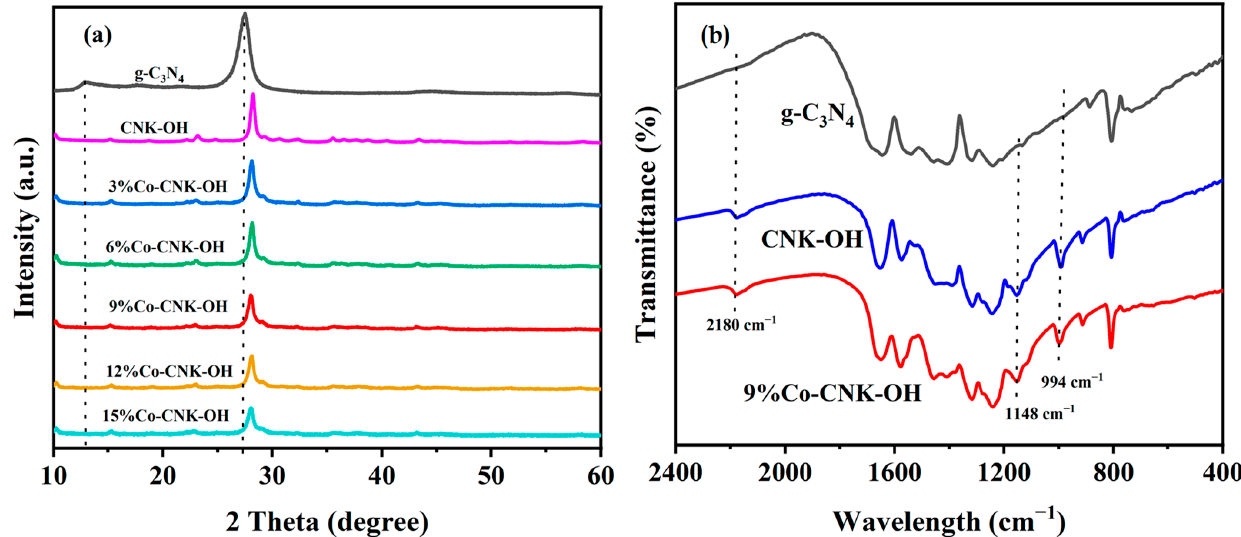
Figure 1. The XRD patterns of g-C 3 N 4 , CNK-OH and Co-CNK-OH ( a ) and FT-IR spectra of g-C 3 N 4 , CNK-OH, and 9%Co-CNK-OH ( b